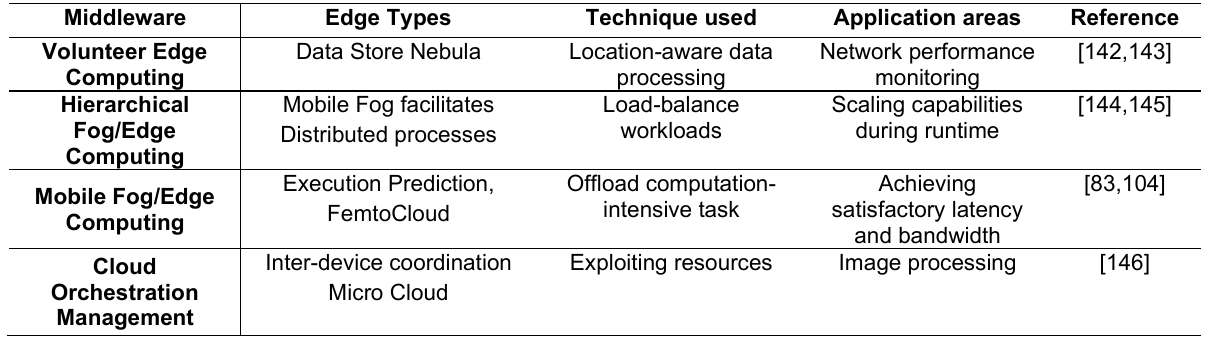
Table 5. Middleware for IoT